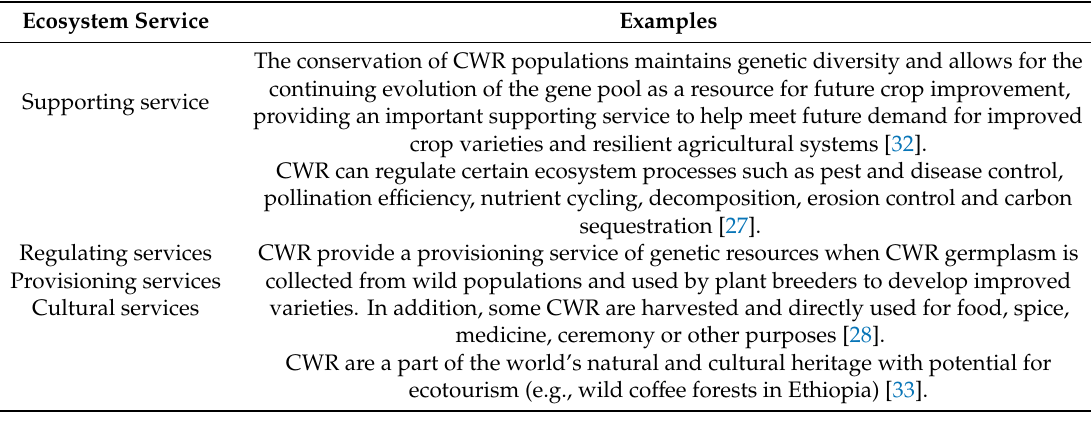
Table 1. List of ecosystem services provided by